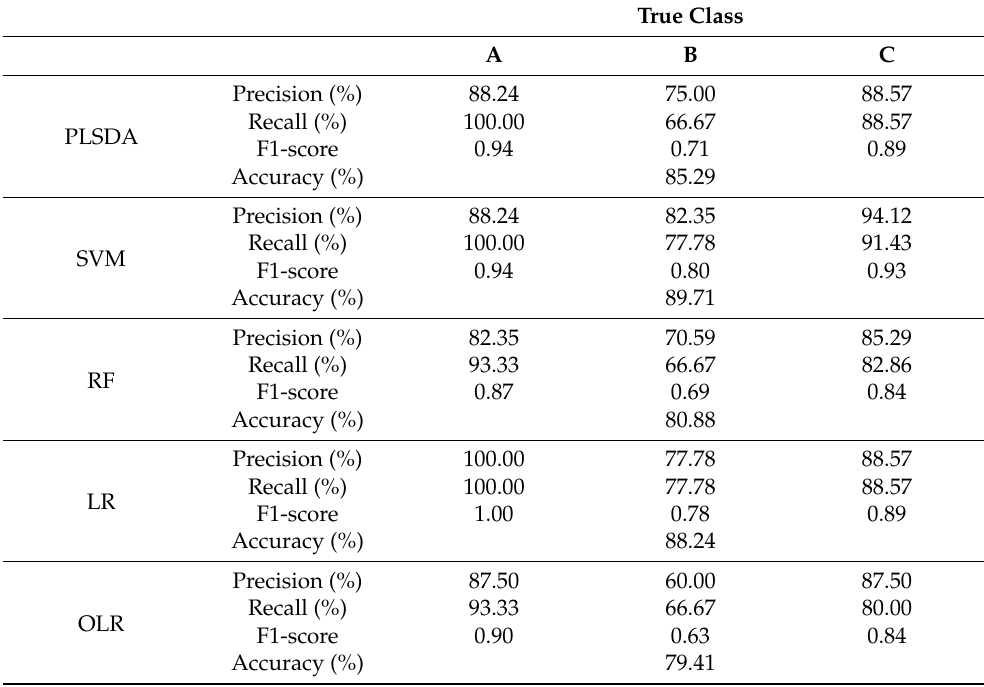
Table 1. Precision (%), recall (%), F1-score, and accuracy (%) for PLSDA, SVM, RF, LR, and OLR classification models for external validation (n = 68) of chicken burger samples using FTIR data, considering three microbiological quality classes: A (satisfactory), B (acceptable), C